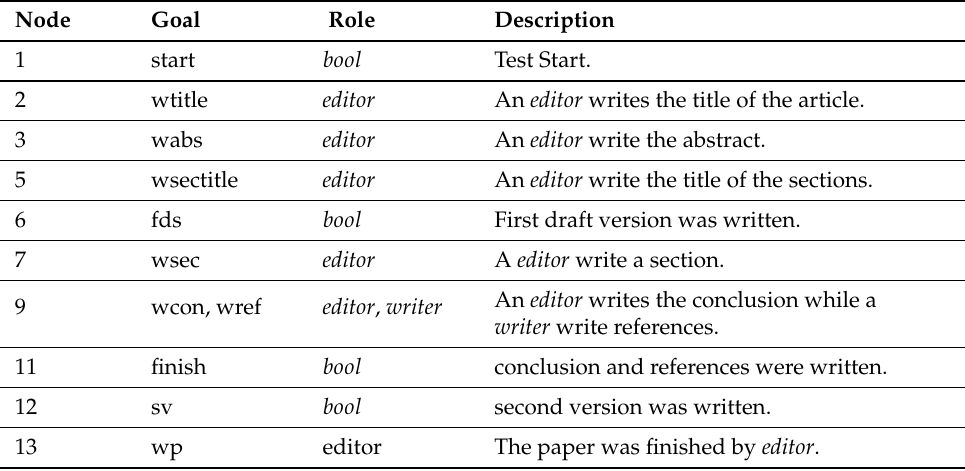
Table 9. A test case for Writing Paper permission